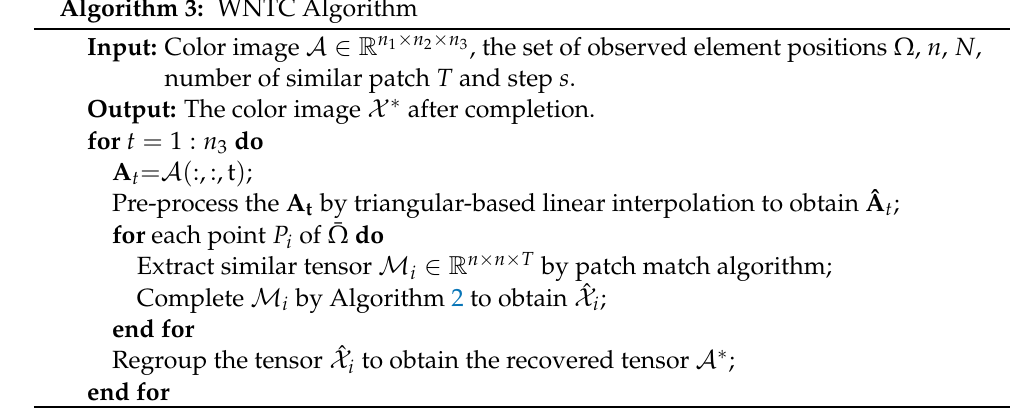
Algorithm 3: WNTC